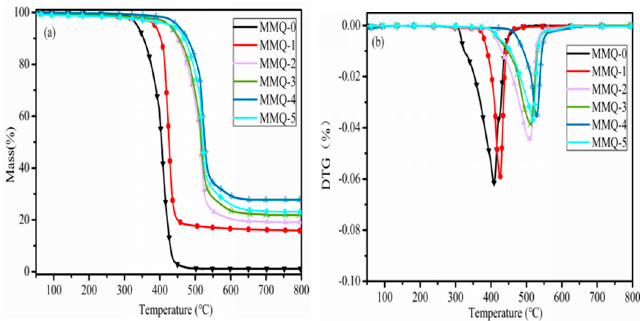
Figure 9. TGA ( a ) and DTG ( b ) curves of RTV silicone rubbers obtained in a nitrogen atmosphere. Table 2. The important characteristic data of TG curing for RTV silicone rubbers obtained in a N 2 atmosphere.